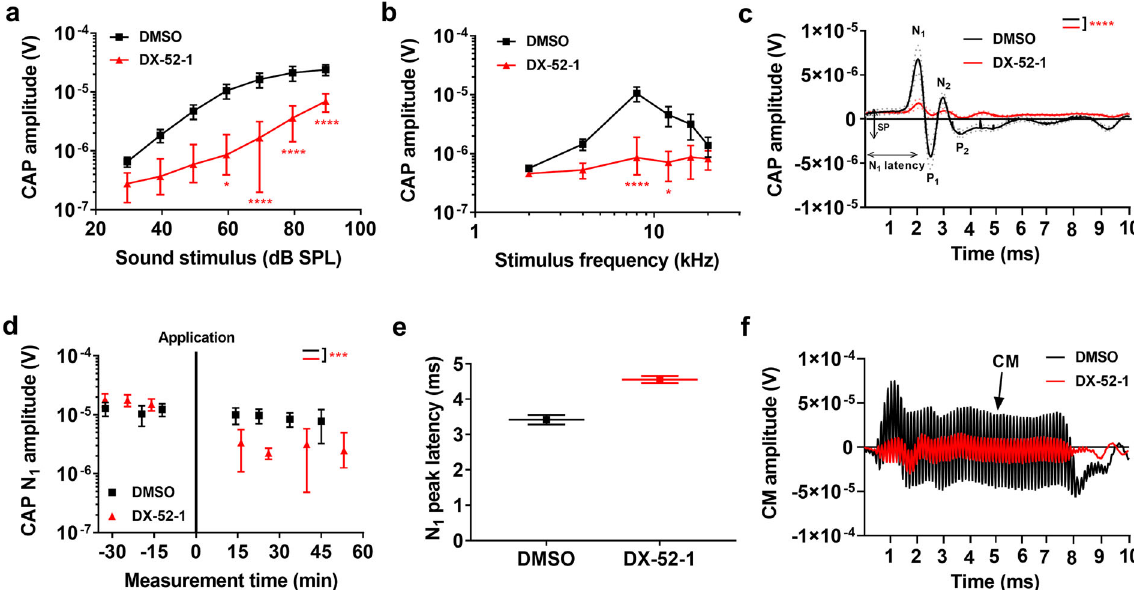
Fig. 5 DX-52-1 results in declining hearing sensitivity, as assessed by the compound action potential of the auditory nerve. a CAP amplitudes as a function of stimulus level at 8 kHz. b CAP amplitudes as a function of stimulus frequency. c Grand average ± s.e.m (dotted) of the CAP waveforms to 60 dB SPL stimuli shows reduction in N1 and N2 amplitudes. d Averaged time courses of the changes seen in N1 amplitude measured at 60 dB SPL 8-kHz stimulus following DX-52-1 application, relative to those before the application, which decreased signi fi cantly after 15 – 20 min of application. e The latency of the CAP N1 increased slightly after DX-52-1 application. f Representative waveforms of the CM potential, before and after 20 min of application of 1 mM DX- 52-1. The stimulus was a 8-KHz tone burst at 90 dB SPL. Data information: DMSO ( n = 10), DX-52-1 ( n = 18). Data are mean ± s.e.m. **** P < 0.0001; *** P < 0.001; ** P < 0.01; * P < 0.05; ns, not signi fi cant; two-way ANOVA coupled to the Bonferroni post hoc test, two-tailed unpaired t- test with Welch ’ s